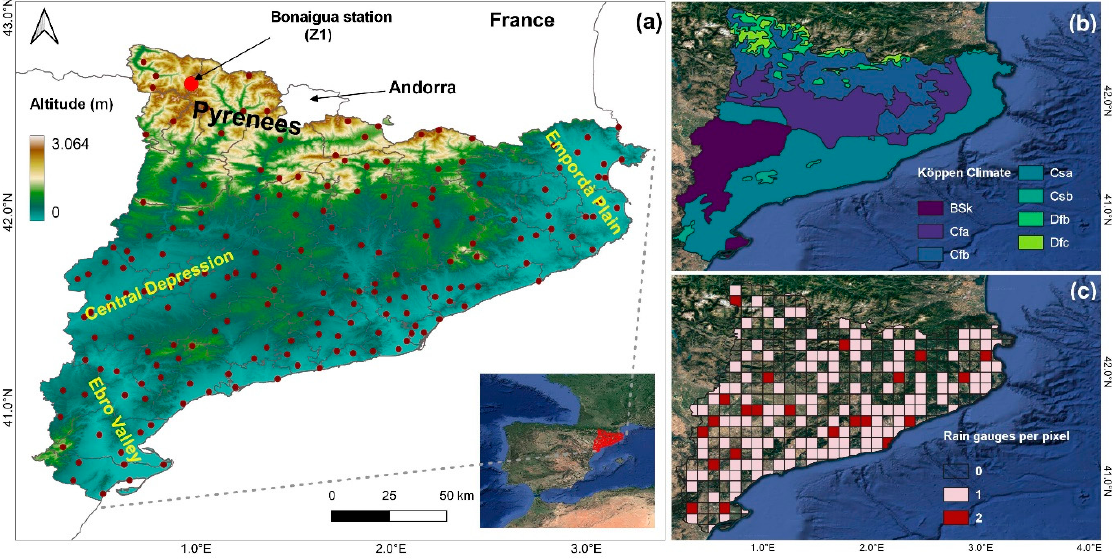
Figure 1. ( a ) Digital elevation model of Catalonia and XEMA stations network distribution. ( b ) Köppen climate classification in the study area. ( c ) Number of XEMA stations per IMERG pixel in the Catalonia domain.